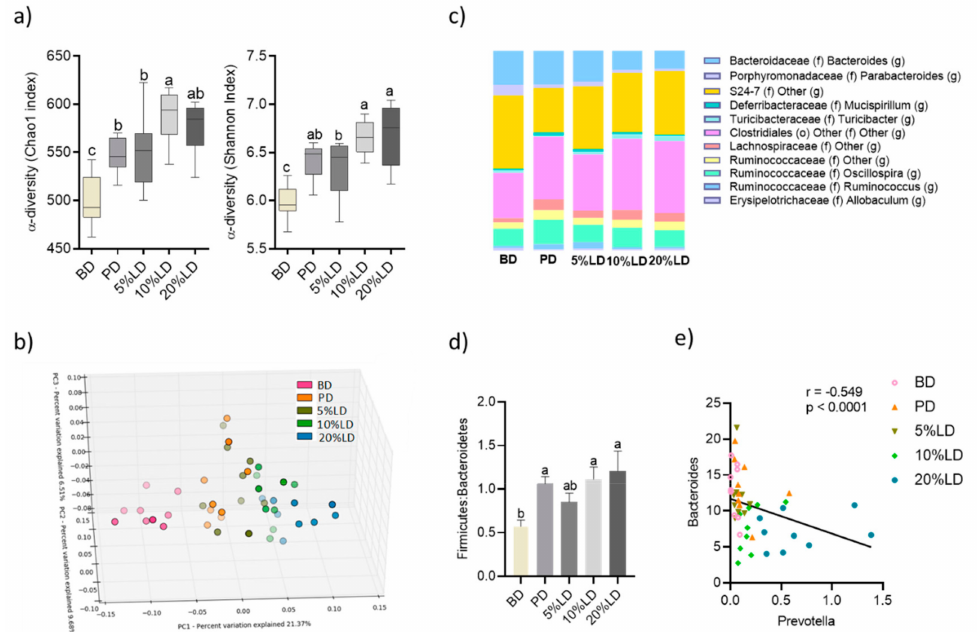
Figure 2. The e ff ects of lentil supplementation on the fecal microbiota composition.( a ) Fecal microbiota α -diversity as measured by Choa-1 and Shannon diversity indices; ( b ) β -diversity as shown by principal coordinate analysis (PCoA) of unweighted UniFrac distance matrices showing bacterial communities cluster within dietary groups and the percent of dataset variability explained by each principal coordinate is shown in the axis titles (Principle coordinate 1(PC1): 21.4%; PC2: 9.7%; PC3: 6.51%); Each dot represents one mouse and each group is denoted by a di ff erent colored symbol (pink: basal diet (BD); orange: pectin diet (PD); dark green: 5% lentil diet (LD); light green: 10% LD; blue: 20% LD); ( c ) microbiota taxa composition at the corresponding order (o), family (f) or genus (g) level (includes taxa representing > 0.5% total composition in at least one sample); ( d ) Firmicutes / Bacteroidetes ratio; values are mean ± SEM; columns without a common letter di ff er significantly ( p < 0.05); ( e ) correlation between Prevotella and Bacteroides abundance calculated by Spearman’s correlation method ( p < 0.05; false discovery rate (FDR): 0.05); each symbol represents one mouse and each group is denoted by a di ff erent colored symbol (pink: BD; orange: PD; dark green: 5% LD; light green: 10% LD; blue: 20%